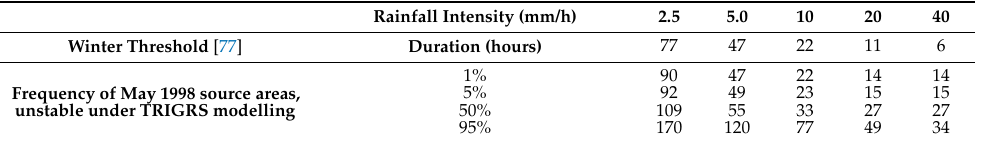
Figure 12. Comparison between frequency curves of initial slides (related to May 1998 landslide event) depending on rainfall intensity considered and duration at the slope failure modelled. Deterministic rainfall thresholds by Napolitano et al. [77] are also shown. Table 2. Duration of rainfall with constant intensity leading to slope failure [77] and durations to slope failure for given frequencies of May 1998 source areas, obtained by TRIGRS